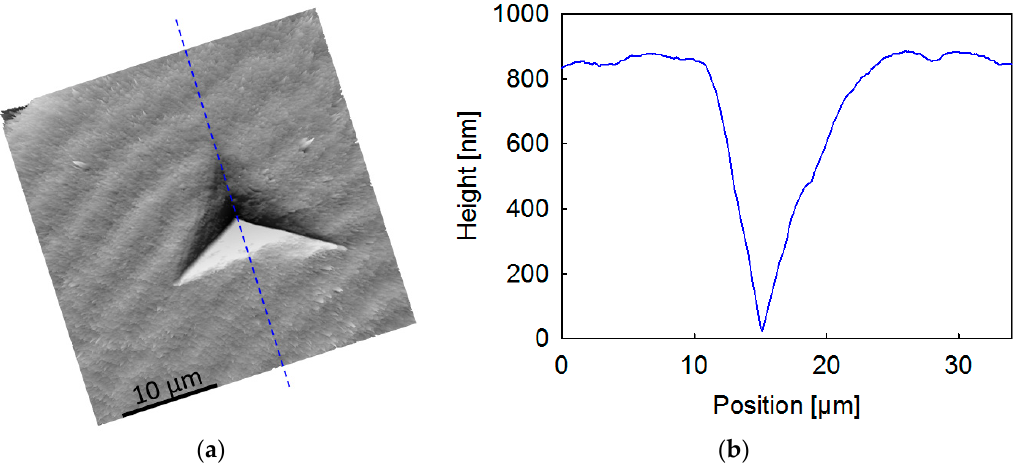
Figure 6. ( a ) AFM image of an indentation produced on the surface of the P3HB-co-3HV spherulite of Figure 5; ( b ) Profile along the blue line marked on ( a ).